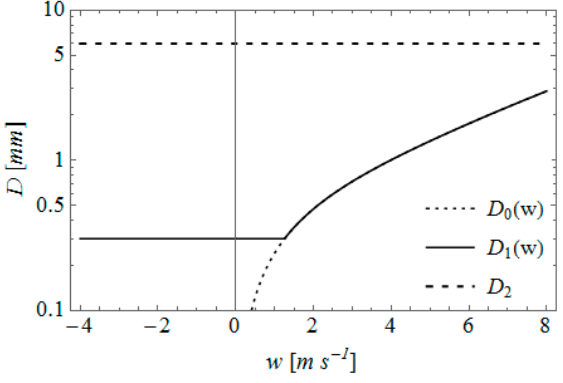
Figure 5. Integration limits of disdrometer DSD.